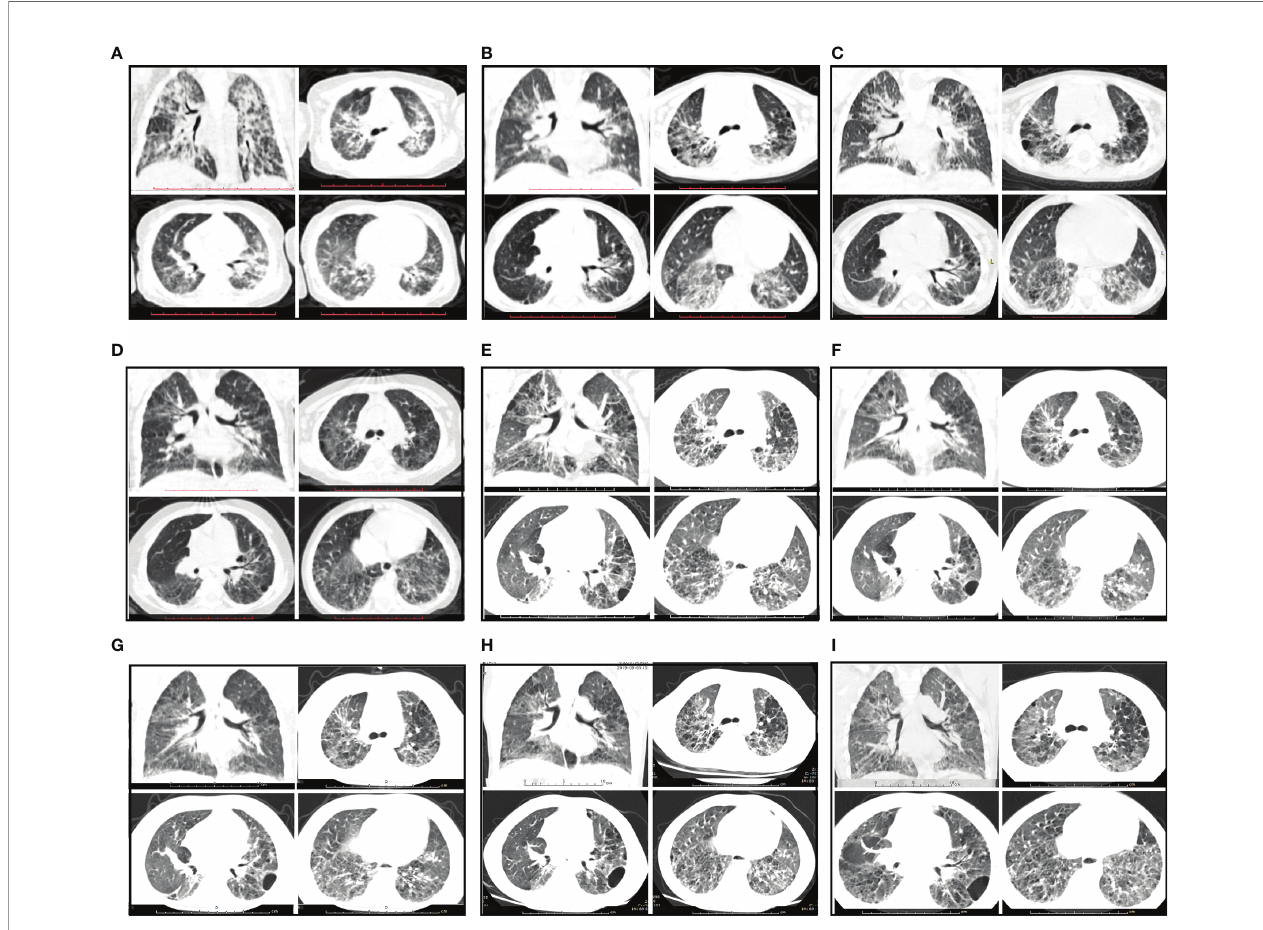
FIGURE 1 | Radiological features during follow-up. (A – C) CT images showing a NSIP + OP pattern and reticular and ground-glass opacities along the bronchovascular bundles with patchy air space consolidation before prednisone treatment. (A) The fi rst chest CT scan at the age of 3 months. (B) The subsequent CT scan at the age of 2 years. (C) The chest CT scan on admission (3 years of age). (D) CT images showing improvement after prednisone treatment for 3 months. (E) CT image showing progressive changes upon relapse of SLE after prednisone treatment for 1 year. (F) CT image showing no signi fi cant improvement after treated with prednisone plus CsA. (G – I) CT images showing improvement of NSIP after treatment with prednisone combined with CsA and pirfenidone for 7 months, 13 months and 26 months,